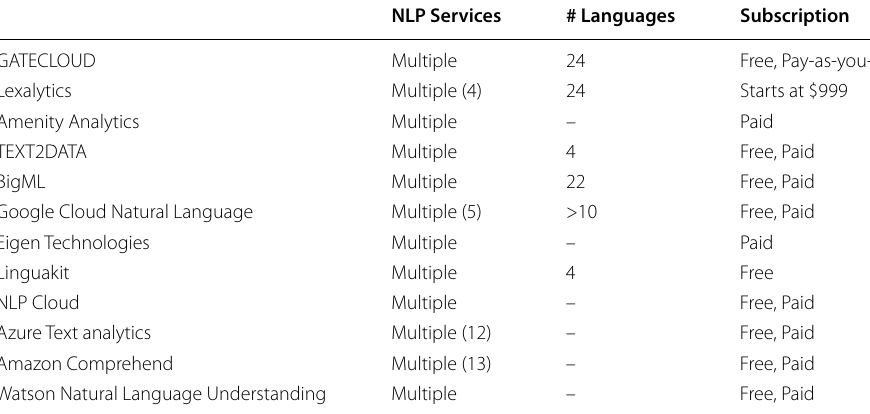
Table 1 Comparison of cloud-based NLP